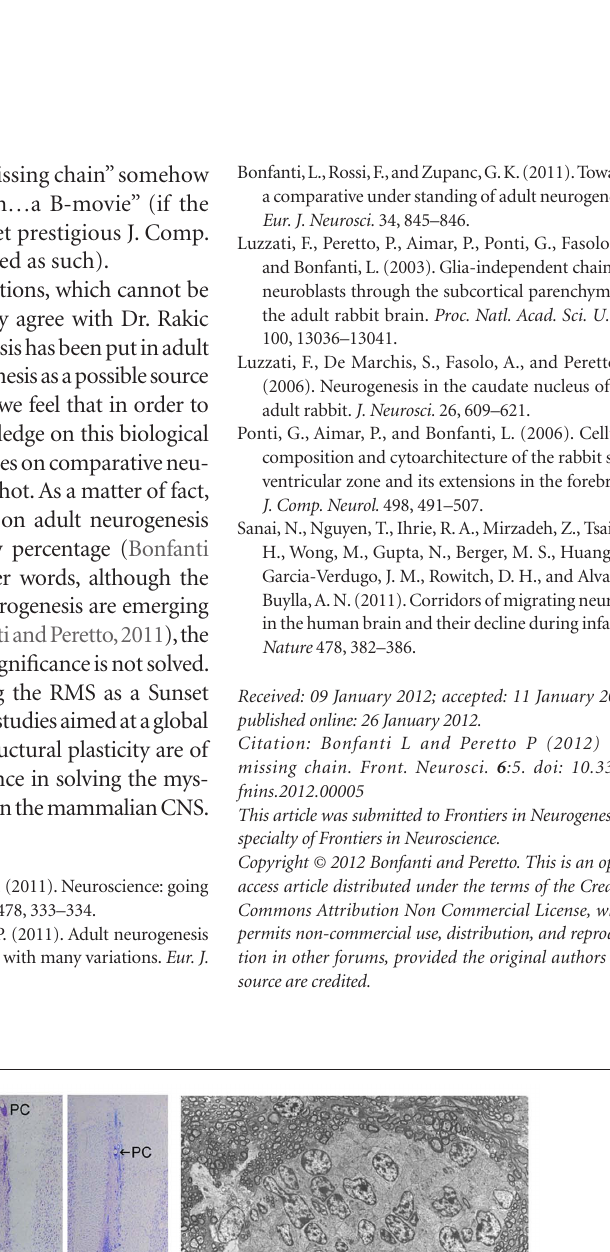
right another parenchymal chain viewed with electron microscopy within the corpus callosum. ov, Olfactory ventricle; DCX, doublecortin (from Ponti et al.,